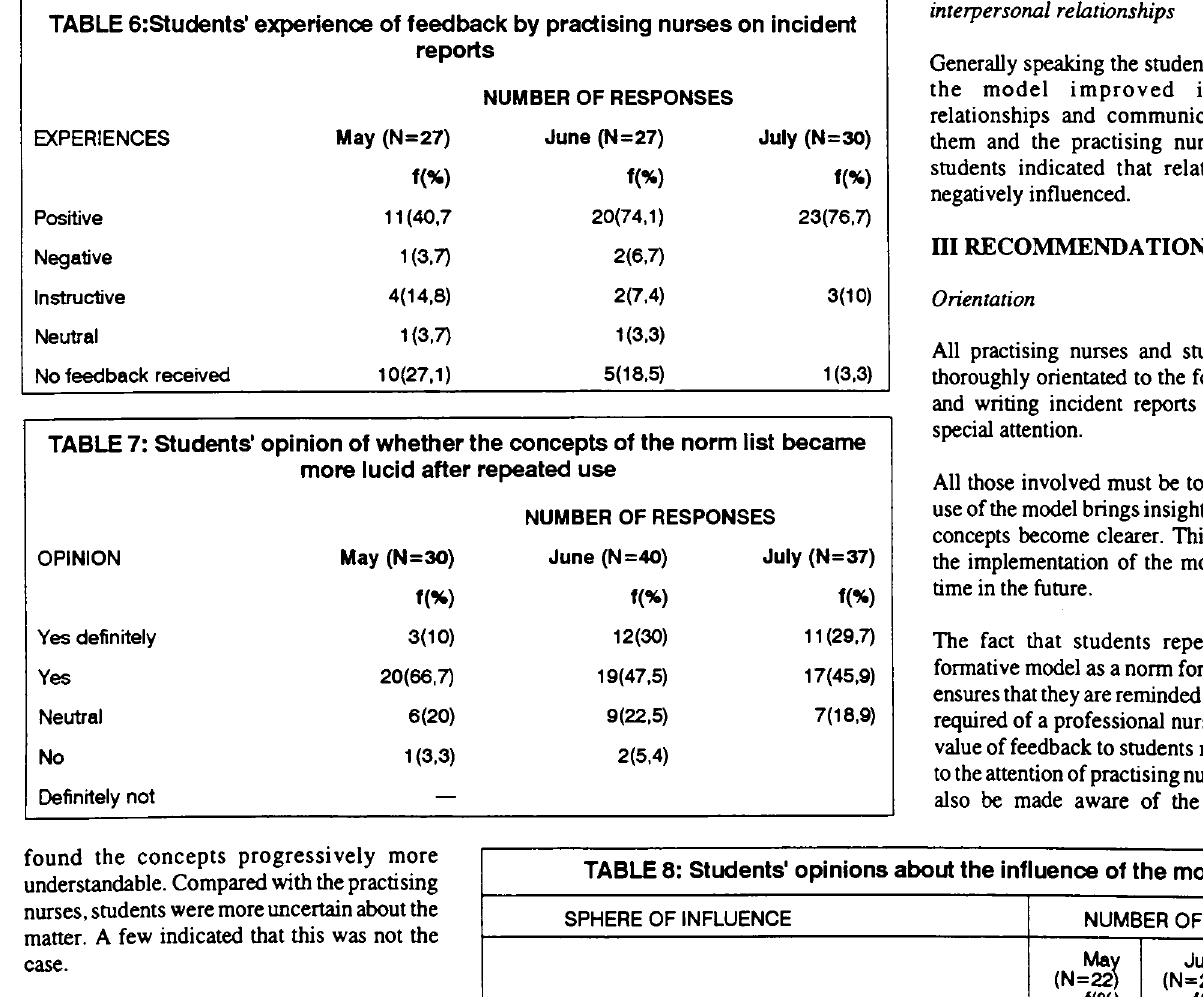
TABLE 8: Students' opinions about the influence of the model SPHERE OF